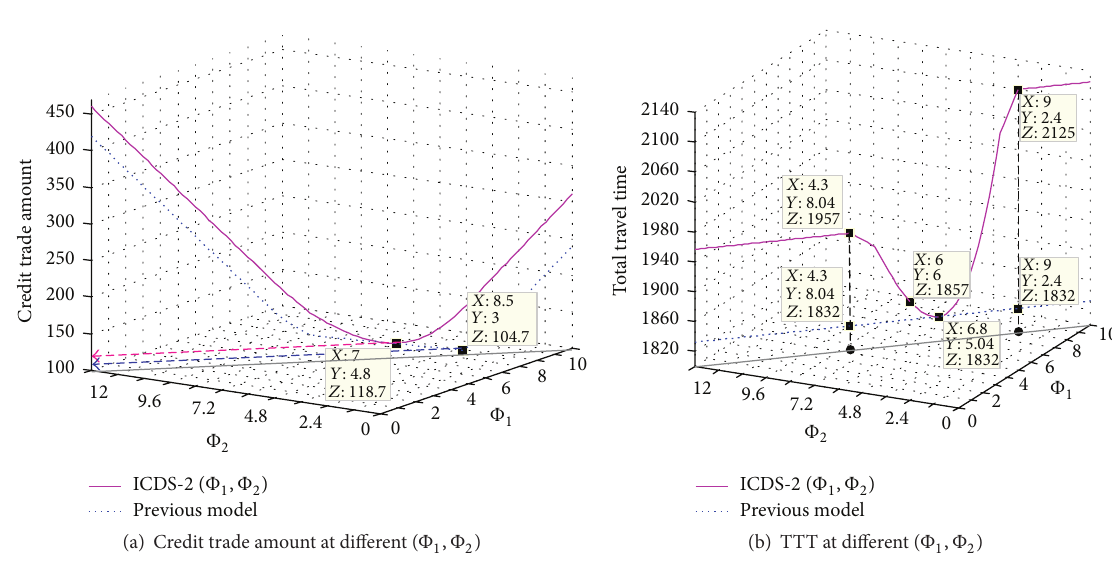
Figure 4: Credit trade amount and TTT at different ( Φ 1 , Φ 2 ) under